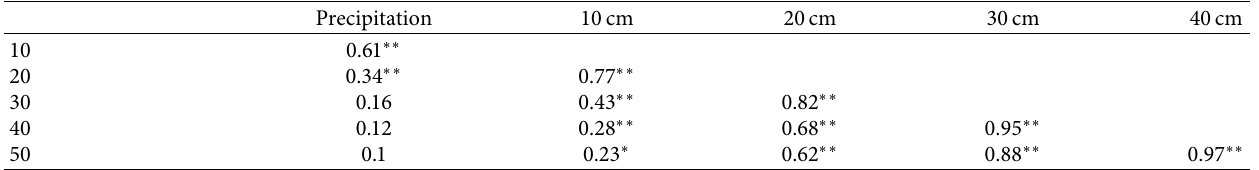
∗∗ and ∗∗ indicate that the correlation coefficients are statistically significant at the 99% and 99.9% levels, respectively (Student’s t -test). Table 2: The lag correlation coefficients between middle and deep layers’ SM and